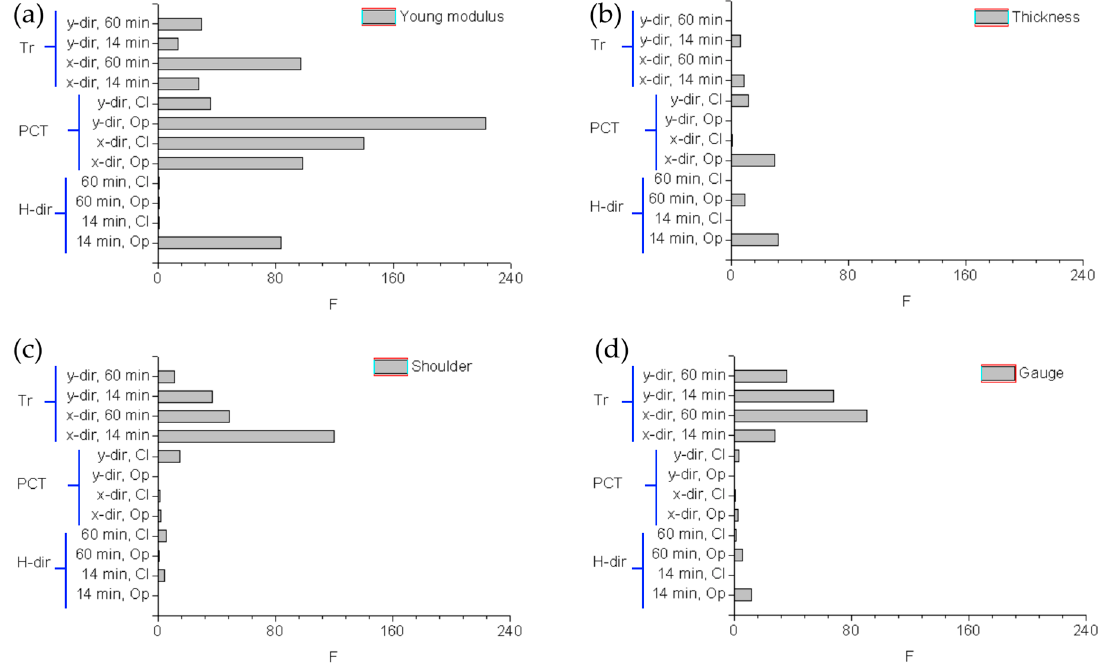
Figure 6. ANOVA: plot of the F values computed for ( a ) Young’s modulus, ( b ) thickness, ( c ) shoulder width, ( d ) gauge width.